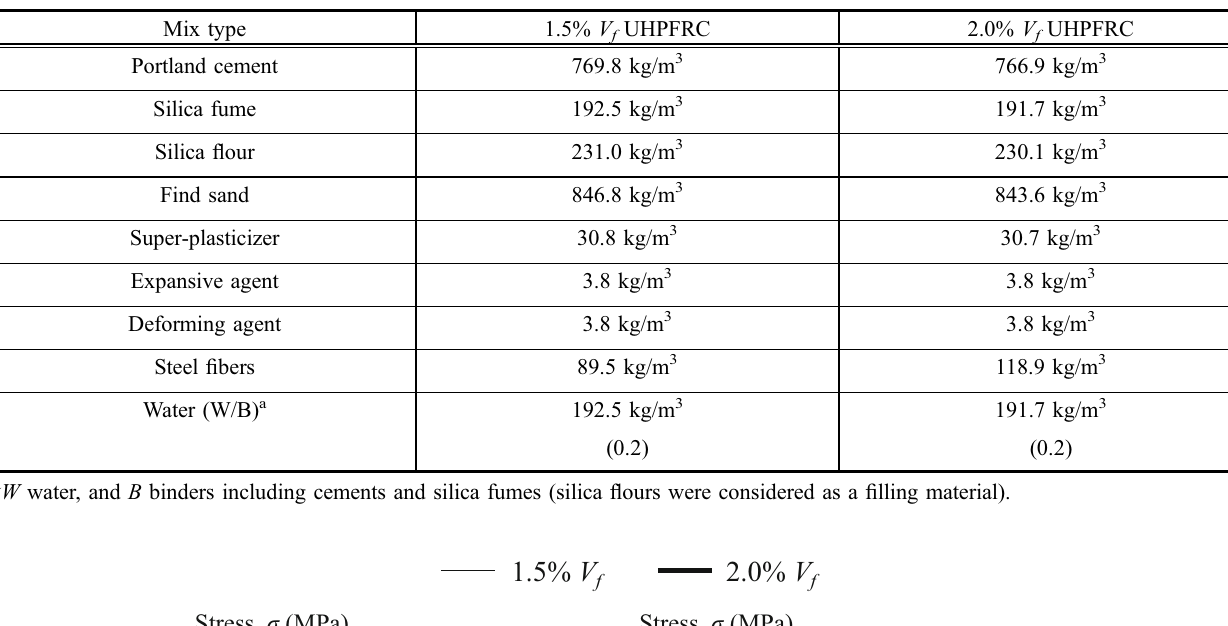
Table 2 Mix design of